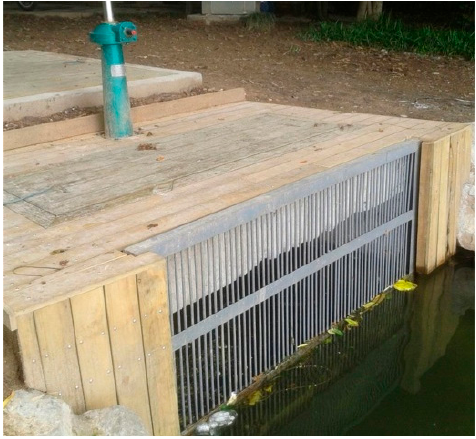
Figure 5. Inlet of the pump station.